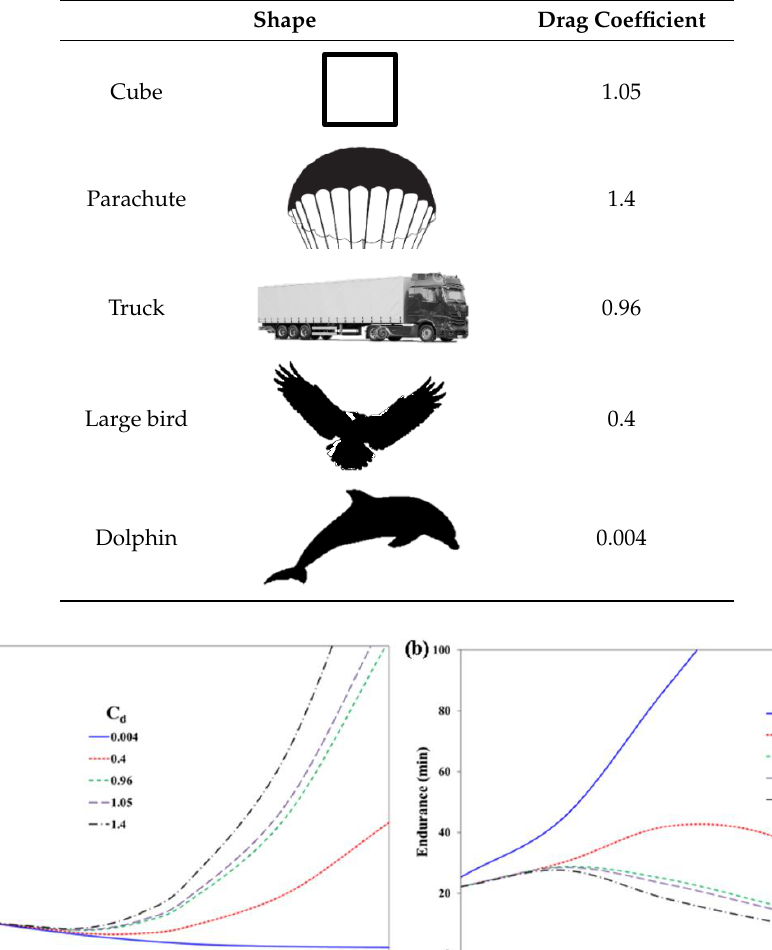
Table 2. Typical drag coefficients of various objects [23,24].